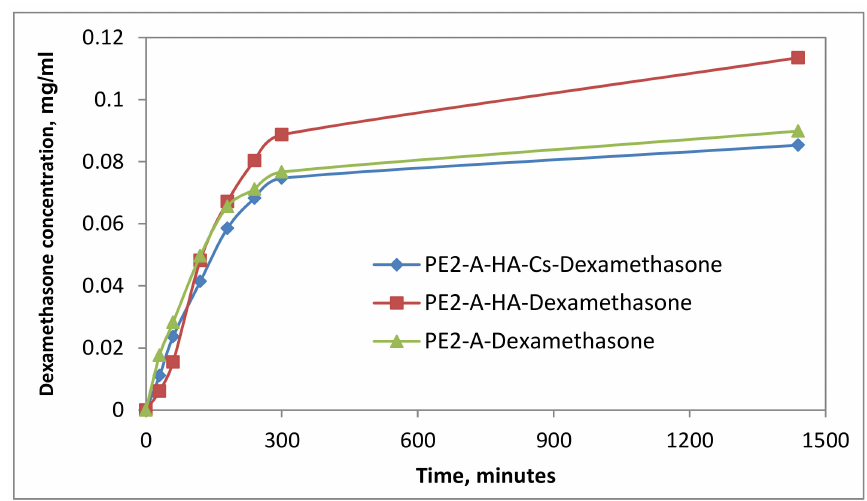
Figure 6. Kinetic curves of dexamethasone release from particulate systems.